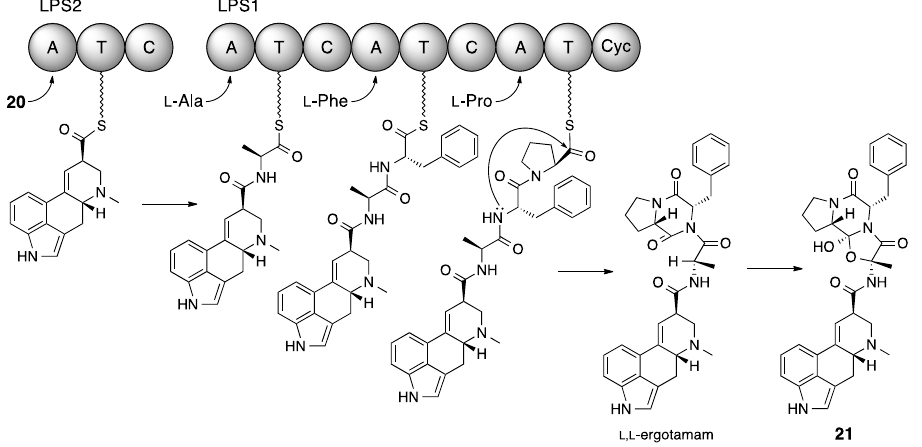
Figure 11. Nonribosomal assembly of the peptide portion of ergotamine 21 , initiated with D -lysergic acid 20 as a primer unit [64]. LPS, D -lysergyl peptide synthetase; C, condensation domain; A, adenylation domain; T, thiolation domain; Cyc, cyclolization domain.